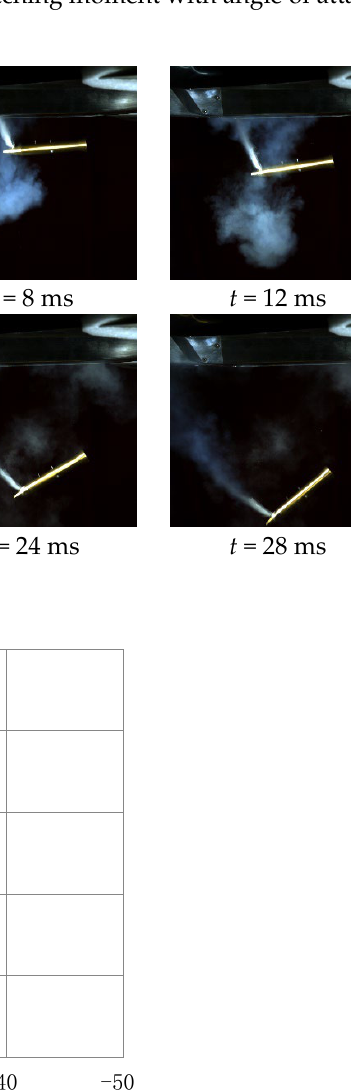
Figure 9. The revolution body pitch for no wind, with and without a jet.